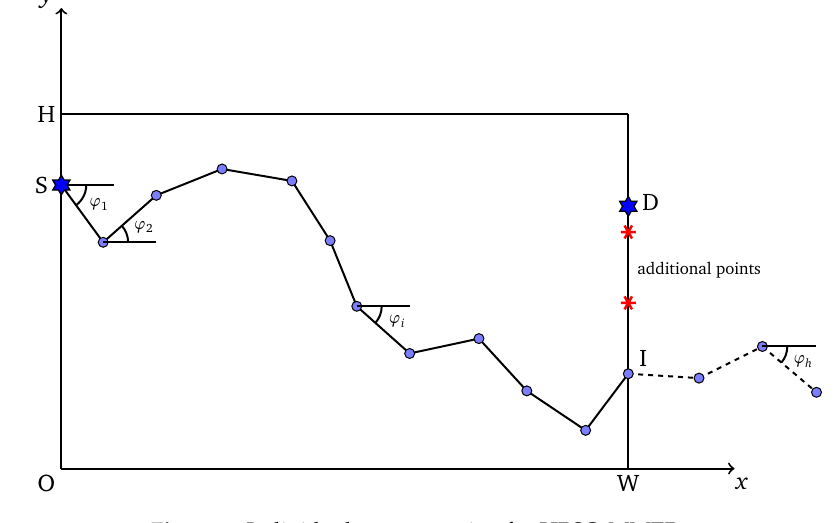
Figure 2. Individual representation for